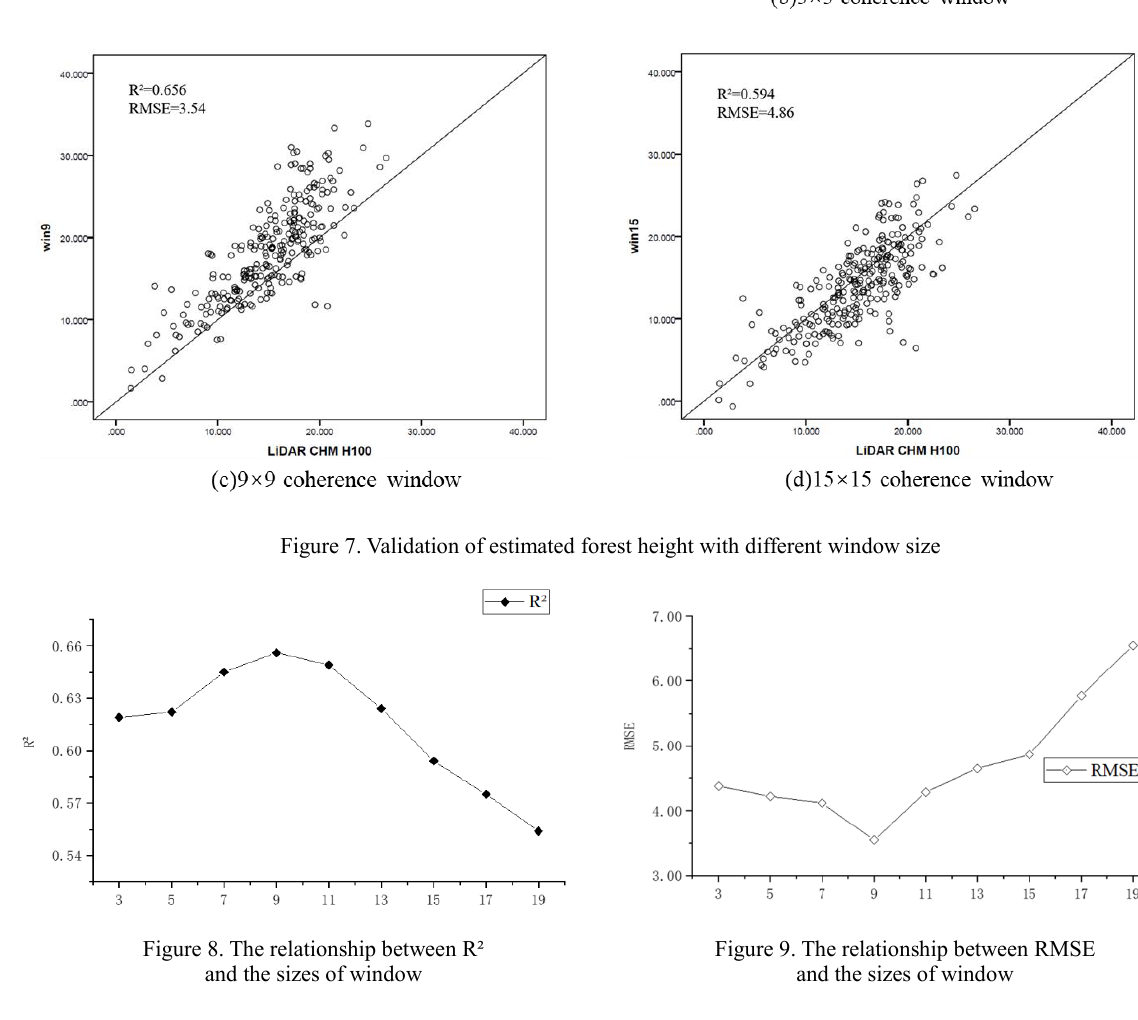
Figure 8. The relationship between R² and the sizes of window